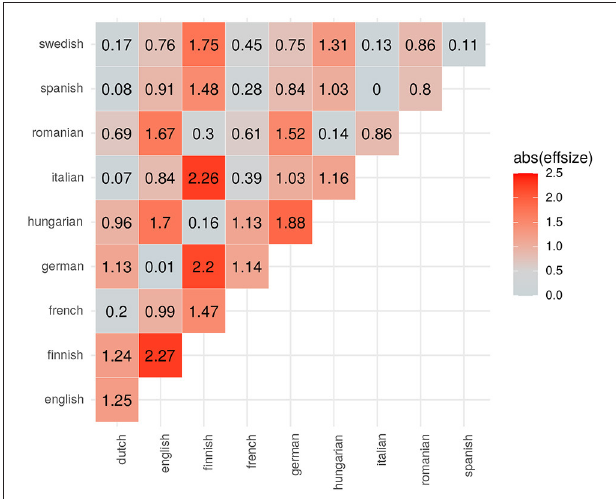
FIGURE 5 | Effect size estimations (Cohen’s d ) for the complexity differences in the meta-analysis of 10